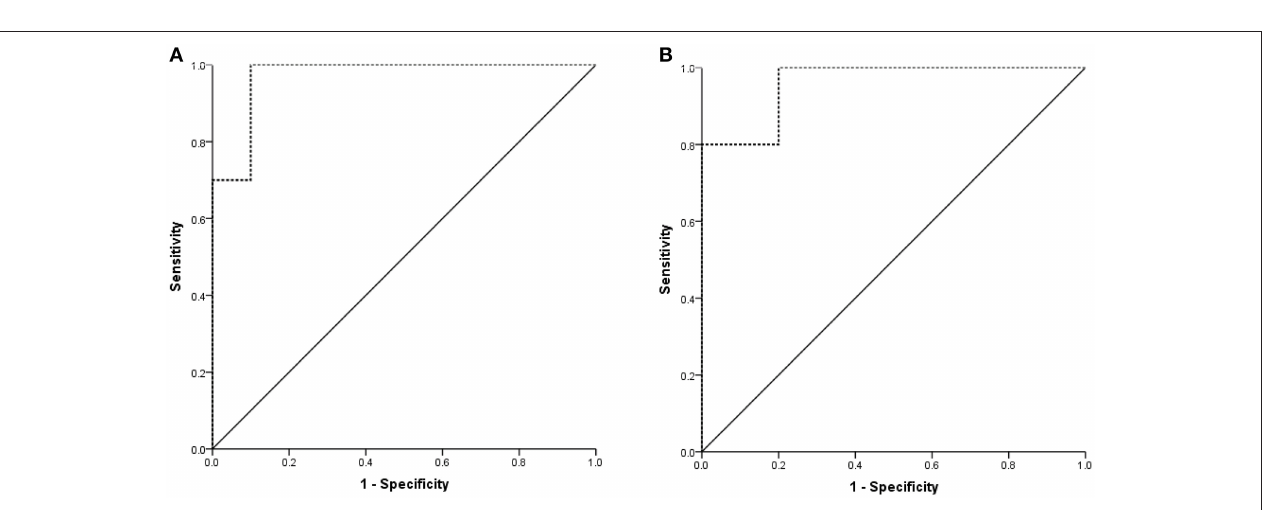
FIGURE 9 | Diagnostic value of plasma exosomal rno-miR-122-5p and rno-miR-300-3p in rats. (A) Sham controls VS 5min ischaemia group; the AUC of plasma exosomal rno-miR-300-3p was 0.970 (95%CI: 0.902-1.000). (B) Sham controls VS 10min ischaemia group; the AUC of plasma exosomal rno-miR-122-5p was 0.960 (95%CI: